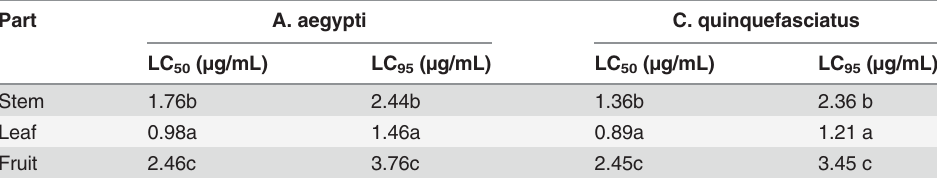
Table 2. LC 50 and LC 95 values of the essential oil from different plant parts of S . guianensis against fourth instar larvae of A . aegypti and C . quinquefasciatus .